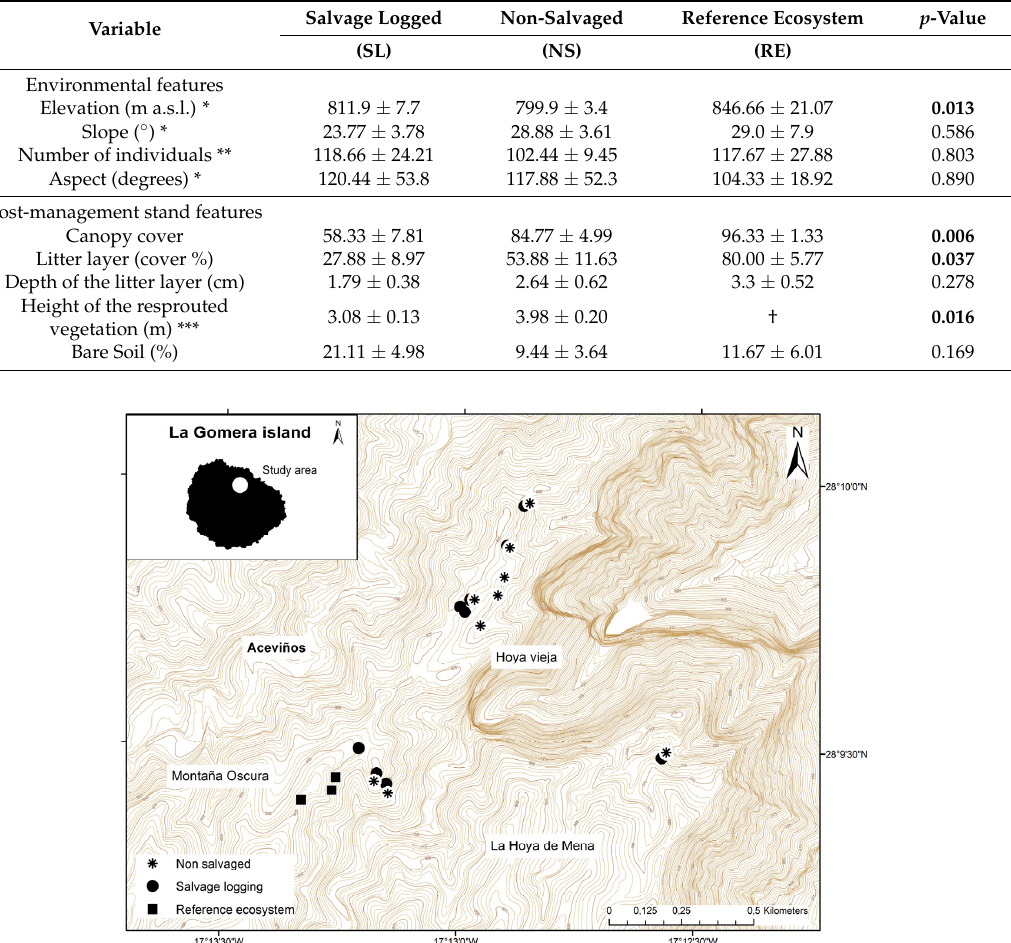
Figure 1. Location of the study area and experimental design.